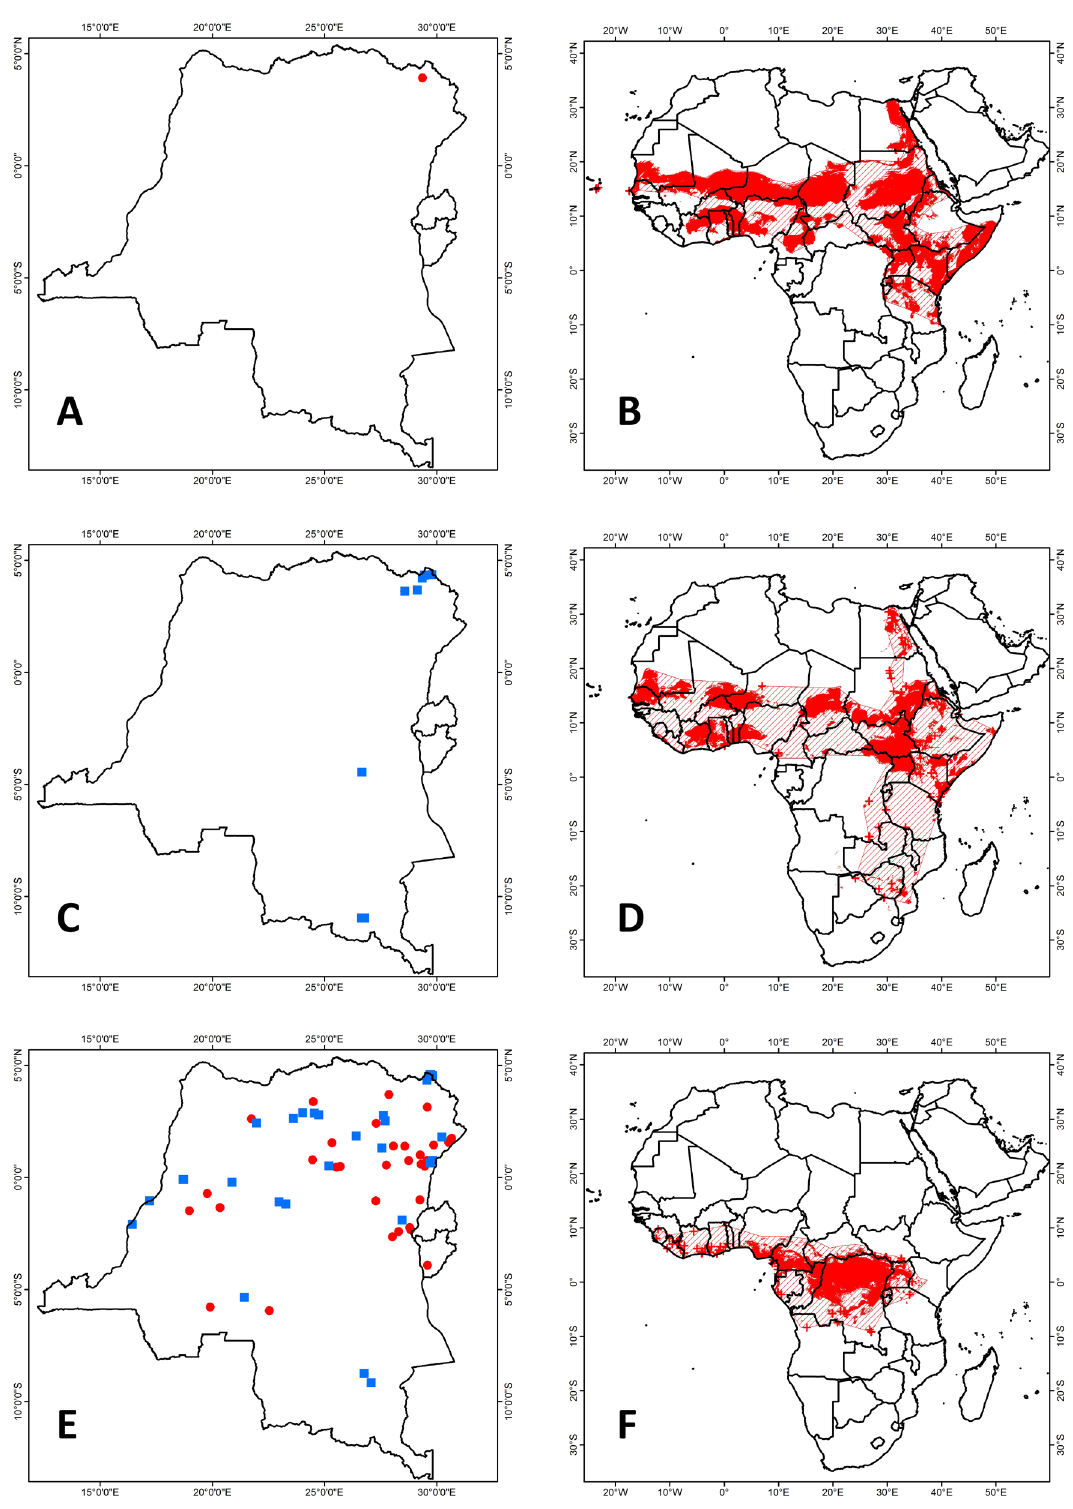
Fig. 20. Distribution maps. A–B . Taphozous nudiventris Cretzschmar, 1830. C–D . Taphozous